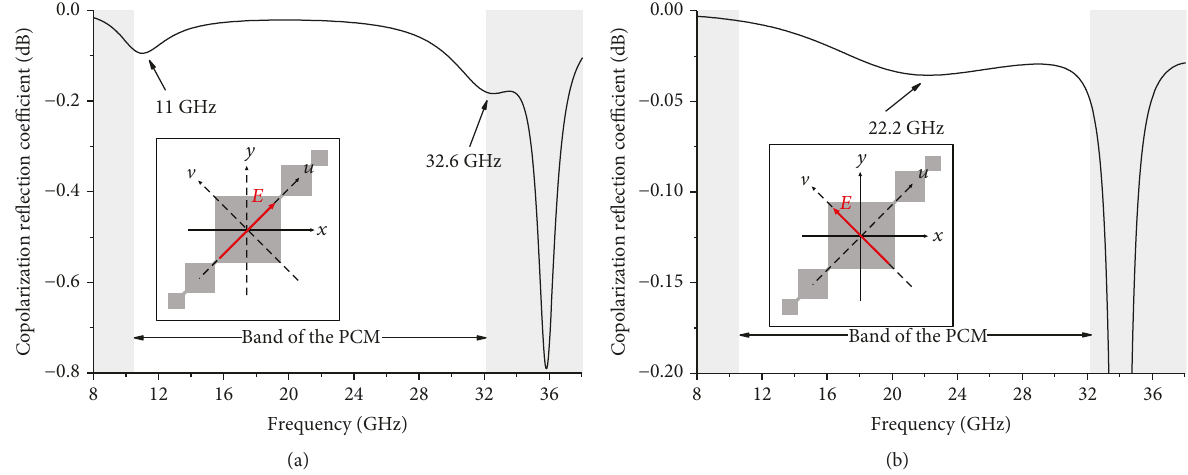
Figure 4: Copolarization re fl ection of u - and v -polarized incidence: (a) u -polarized incidence; (b) v -polarized